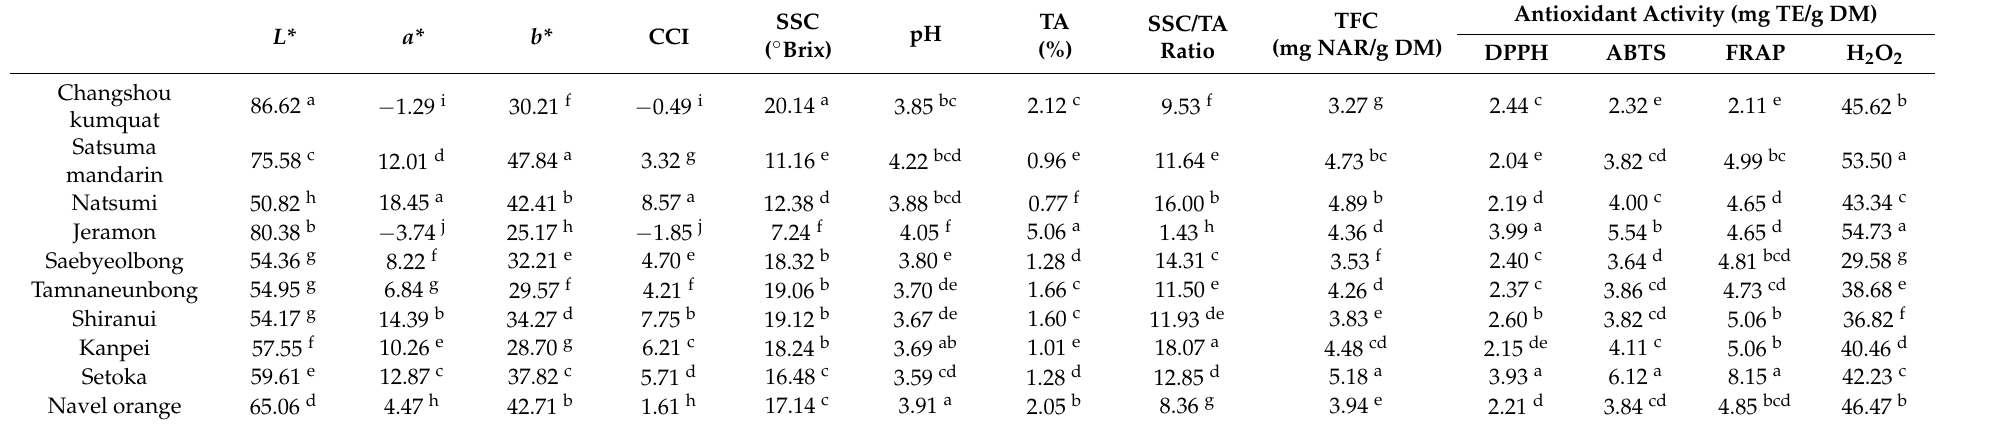
Table 1. General characteristics, total flavonoid content, and antioxidant activities of the flesh of citrus